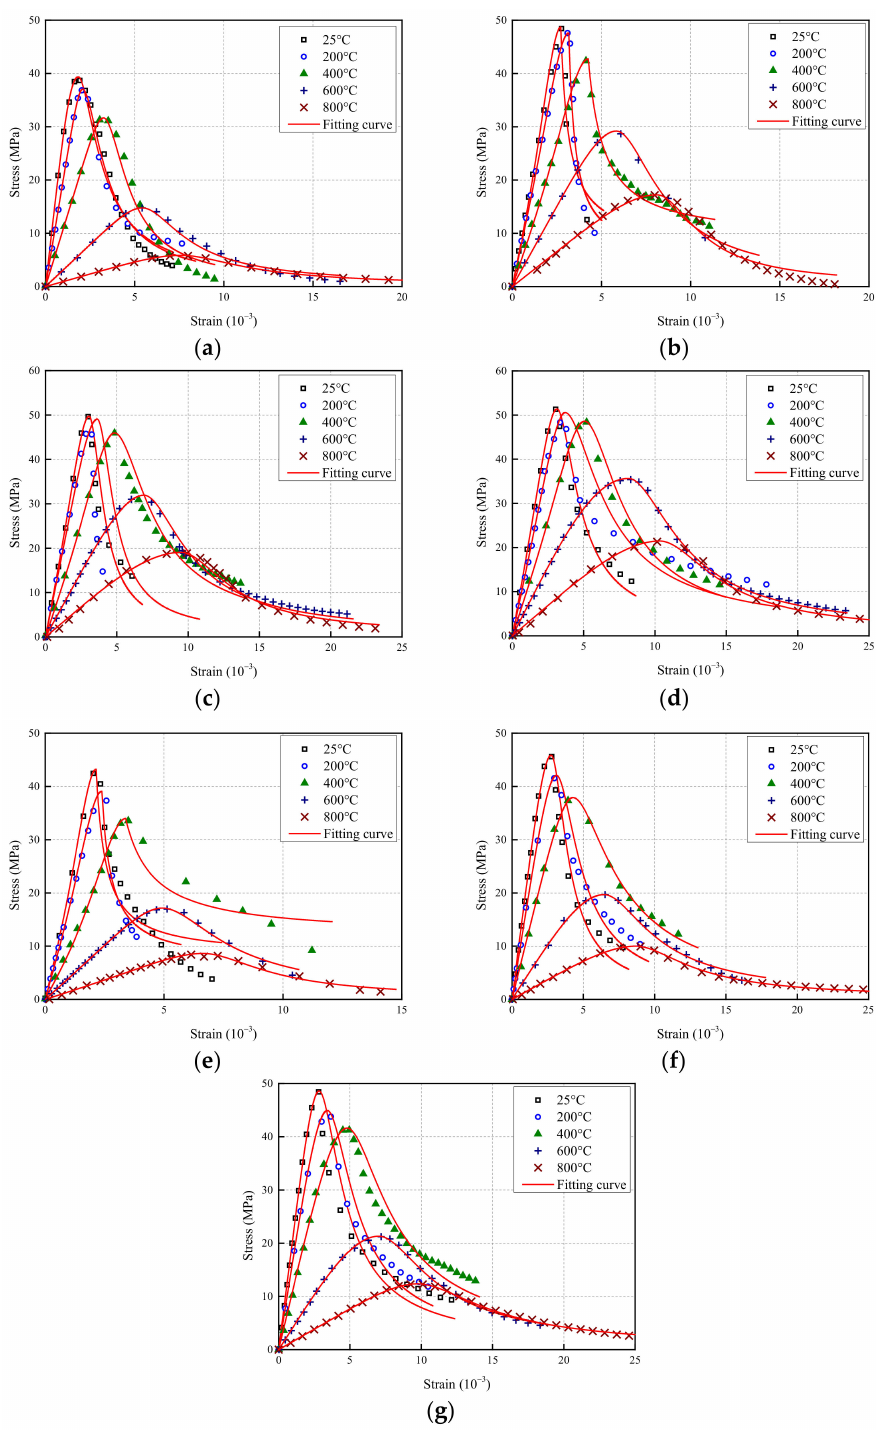
Figure 15. Comparison of the developed stress–strain relationships and experimental results: ( a ) NWC; ( b ) ALWC; ( c ) CFAL; ( d ) HFAL; ( e ) SLWC; ( f ) CFSL; ( g )